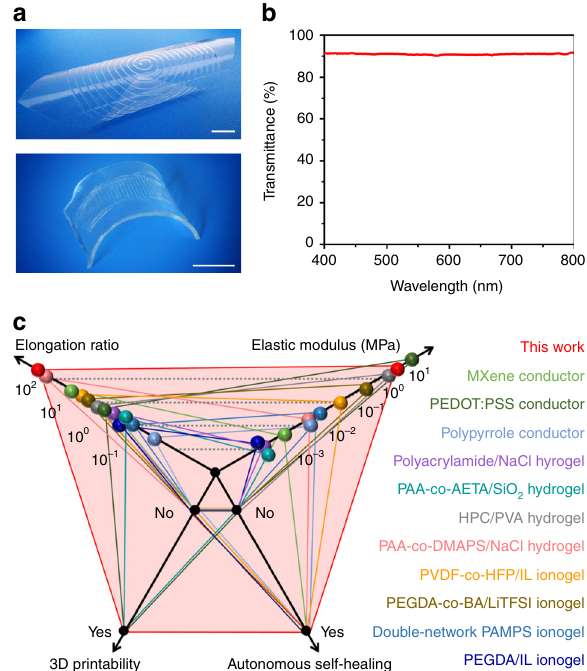
Fig. 3 3D printability, transparence, and comparisons. a Photographs showing 3D-printing conductors on a polyethylene fi lm (the above) and inside of two VHB elastomers (the bottom) (scale bar: 2cm). b The transmittance of the intrinsically stretchable conductor with a thickness of 0.1mm in the visible wavelength range of 400 – 800nm. c A comparison between this work and previously-reported intrinsically stretchable conductors in terms of stretchability, modulus, self-healability and 3D printability 8,11,12,18,20 – 22,40 –